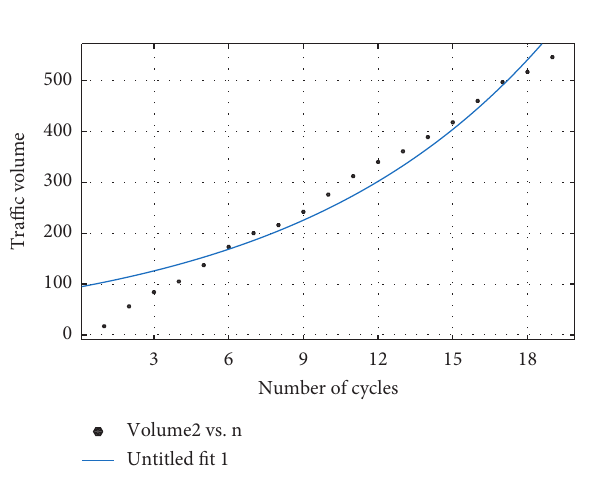
Figure 4: Data fitting of traffic